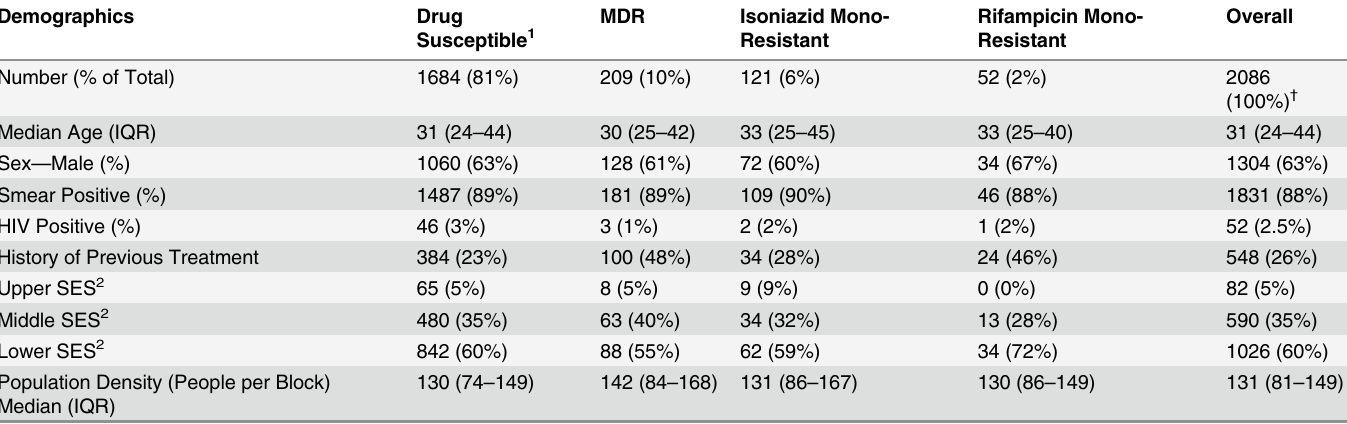
Table 1. Demographic Details for All Genotyped Patients included in the